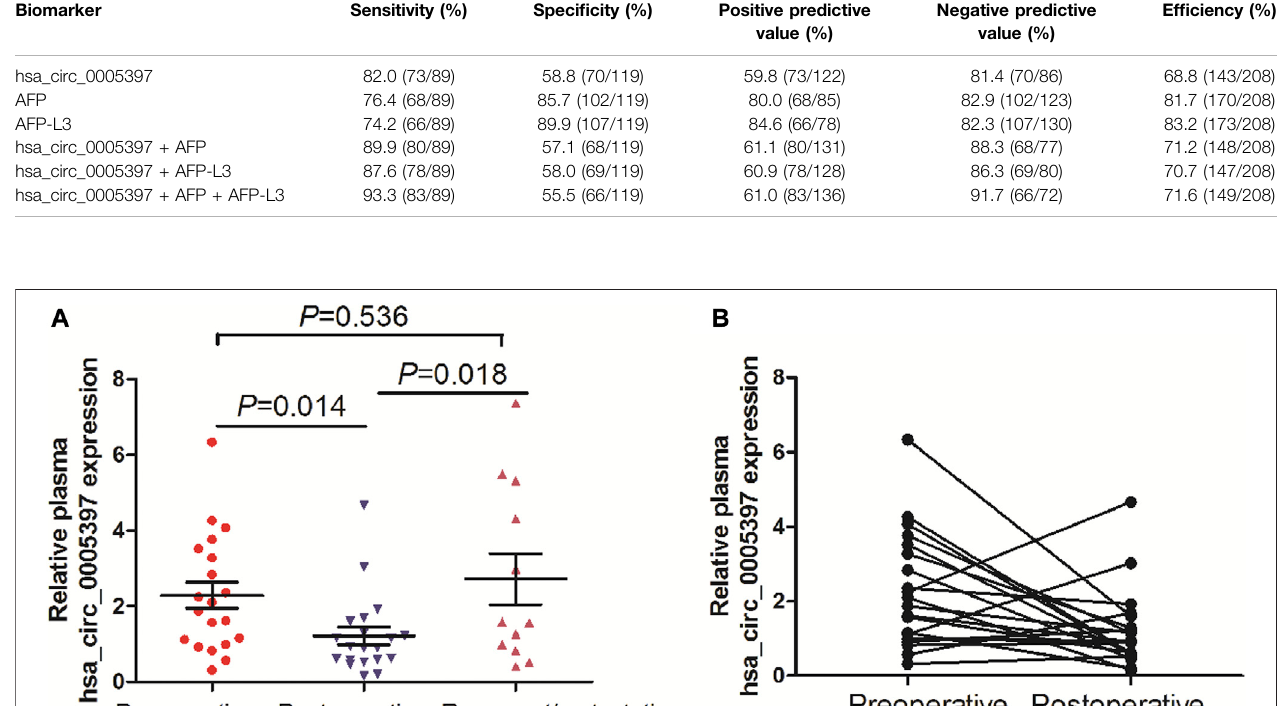
TABLE 3 | Diagnostic value of HCC by plasma hsa_circ_0005397, serum AFP and AFP-L3. Biomarker